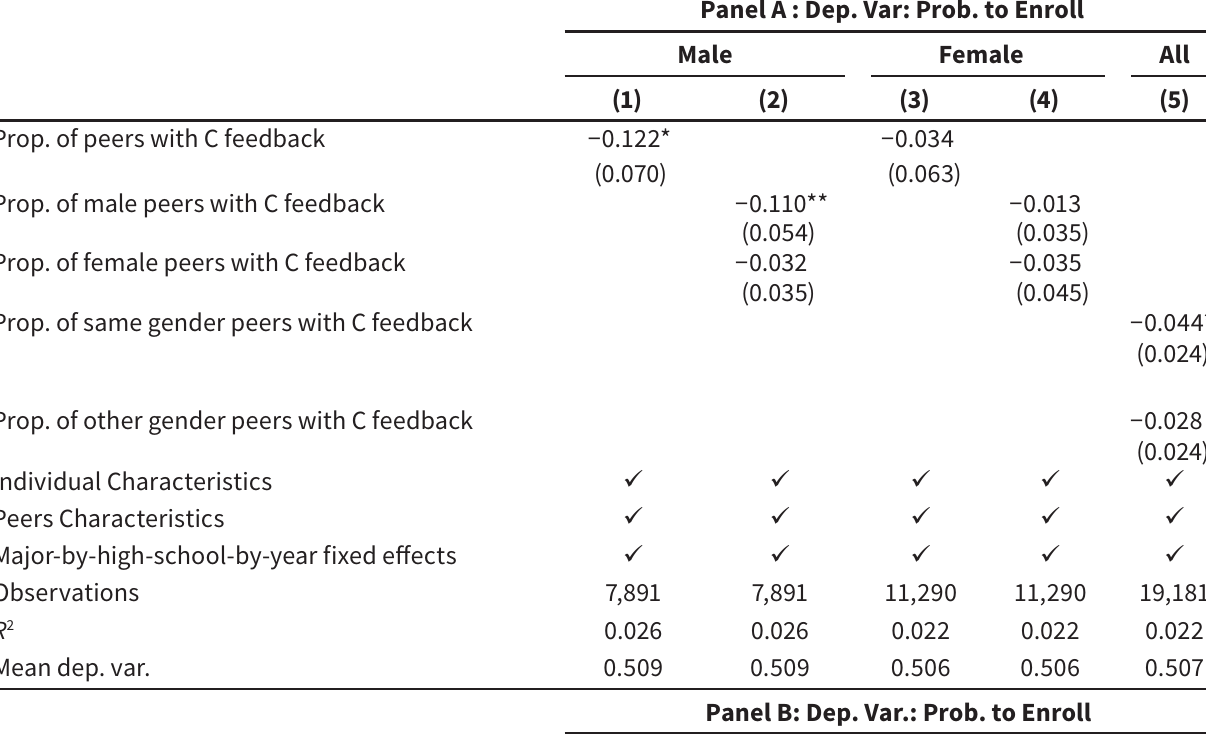
Panel A : Dep. Var: Prob. to